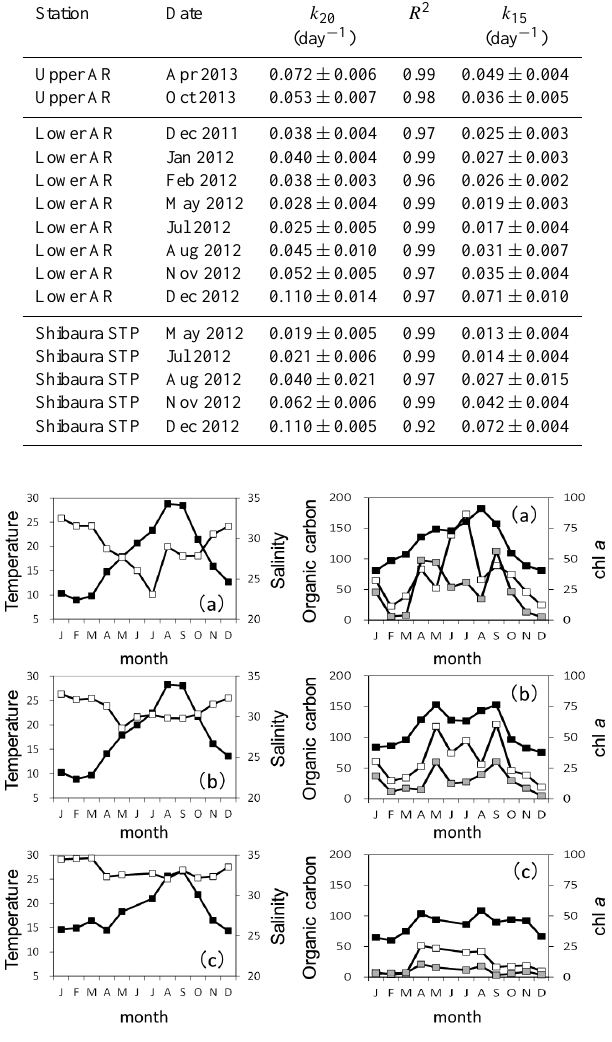
Figure 3. Seasonal variations in salinity (white square), tempera- ture ( ◦ C; black square), dissolved organic carbon (µmolL − 1 ; black square), particulate organic carbon (µmolL − 1 ; white square), and chlorophyll a (µgL − 1 ; gray square) at stations (a) F3, (b) F6, and (c)